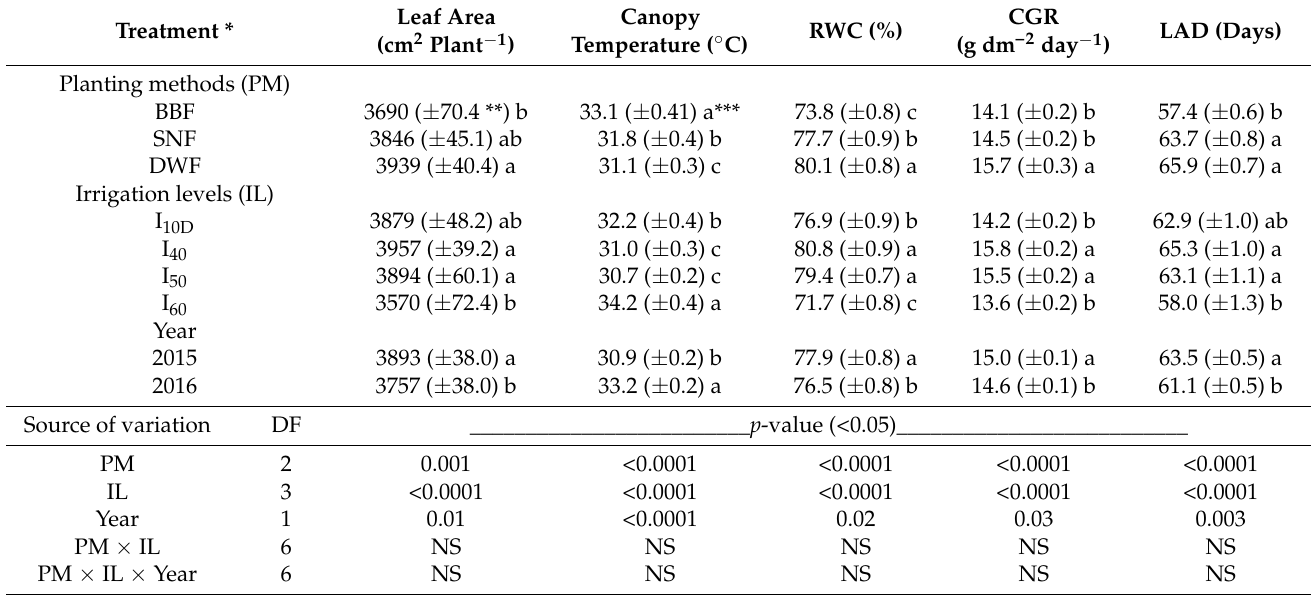
Table 1. Effect of planting methods and irrigation levels on leaf area, canopy temperature, leaf relative water content (RWC), crop growth rate (CGR), and leaf area duration (LAD) of maize at 60 DAS in Dharwad, India. Treatment * Planting methods (PM)